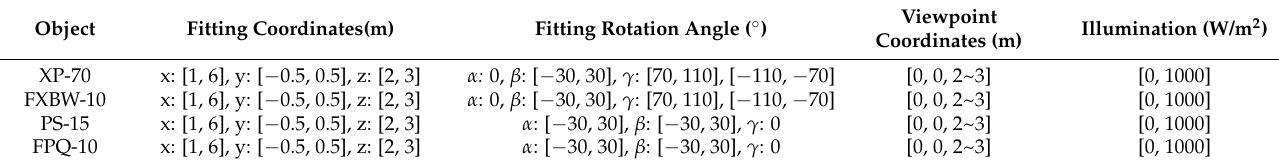
Table 4. Important parameters for the prior series data.